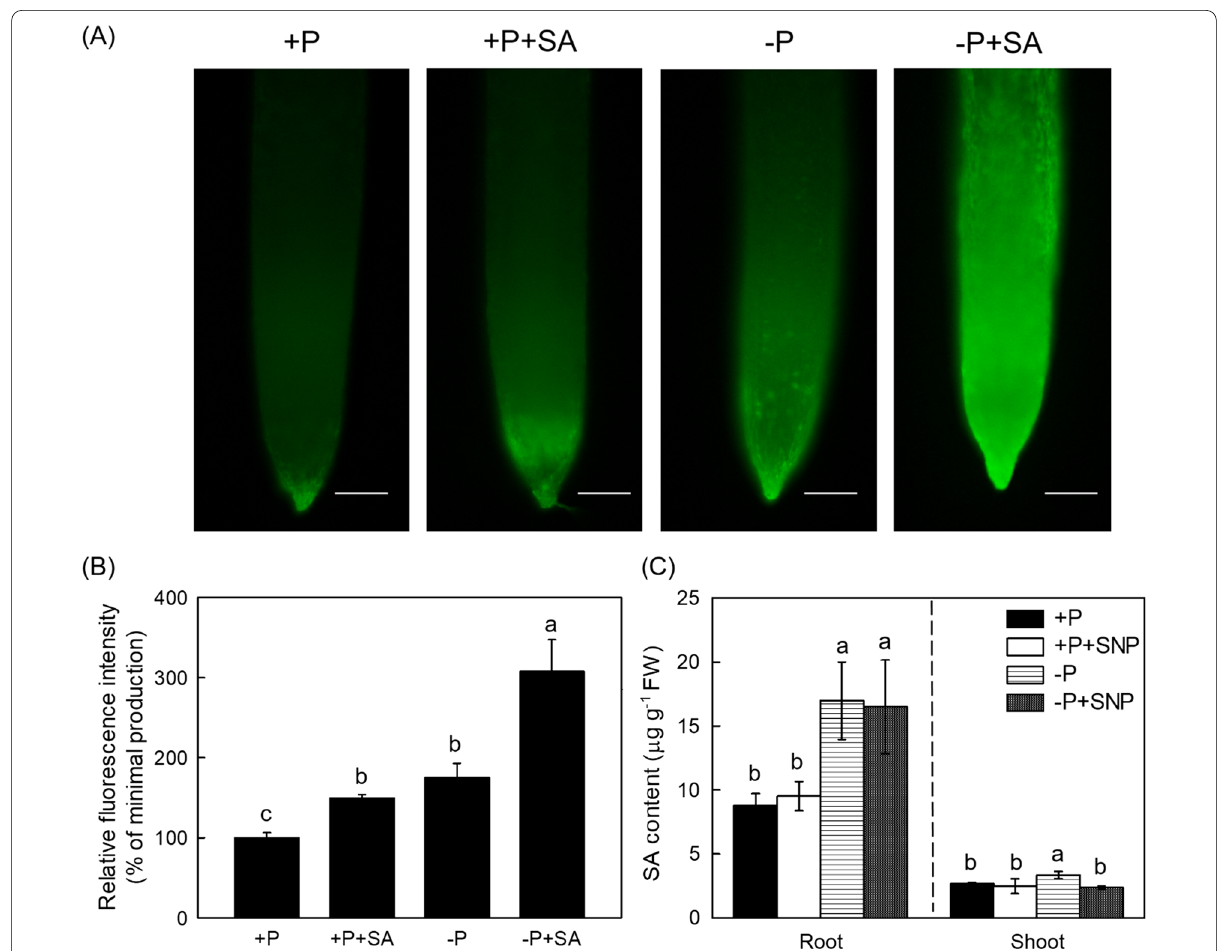
Fig. 6 SA enhances the NO production in response to P deficiency in rice. Root endogenous NO staining ( A ) indicated by green fluorescence and NO production ( B ) described as relative fluorescence intensity (% of minimal production) under respective conditions were displayed. Root and shoot SA content (C) in P‑limited condition with or without SNP supply were measured. Data are means n 8 for root NO detection). Different letters represent significant differences by Duncan’s multiple range test at the P < 0.05. Scale bar =